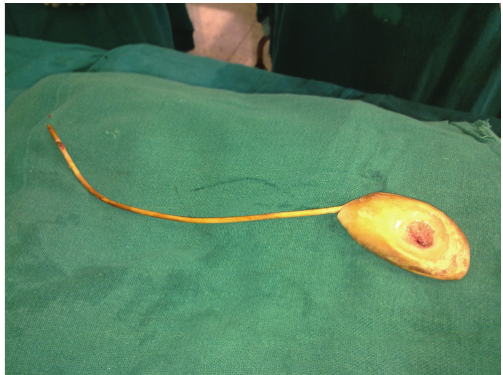
Figure 2: Intraoperative. Removed DJ stent with the calculus at its distal